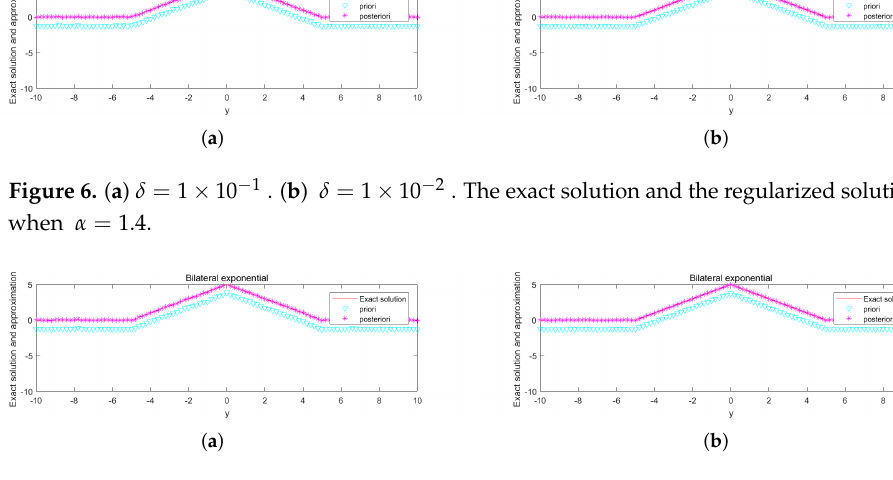
Figure 7. ( a ) δ = 1 × 10 − 1 . ( b ) δ = 1 × 10 − 2 . The exact solution and the regularized solution of b ( x ) when α = 1.8.